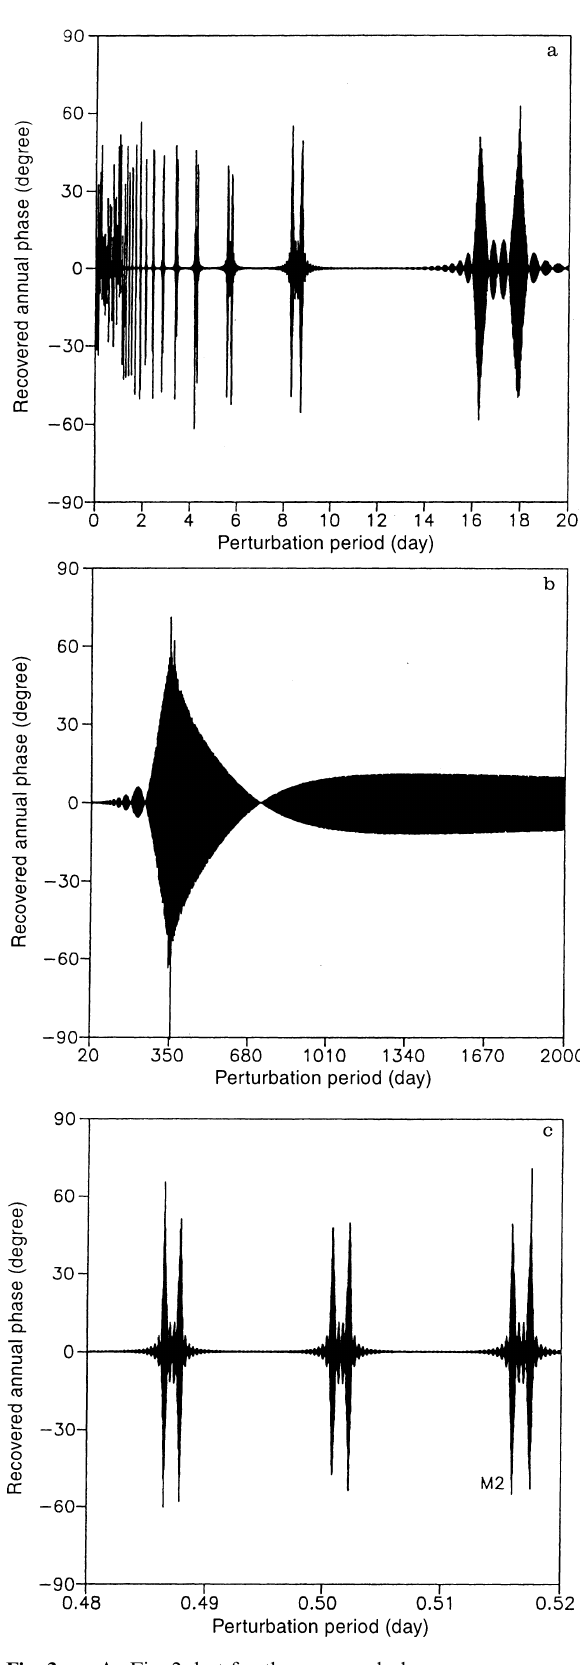
Fig. 3a–c. As Fig. 2, but for the